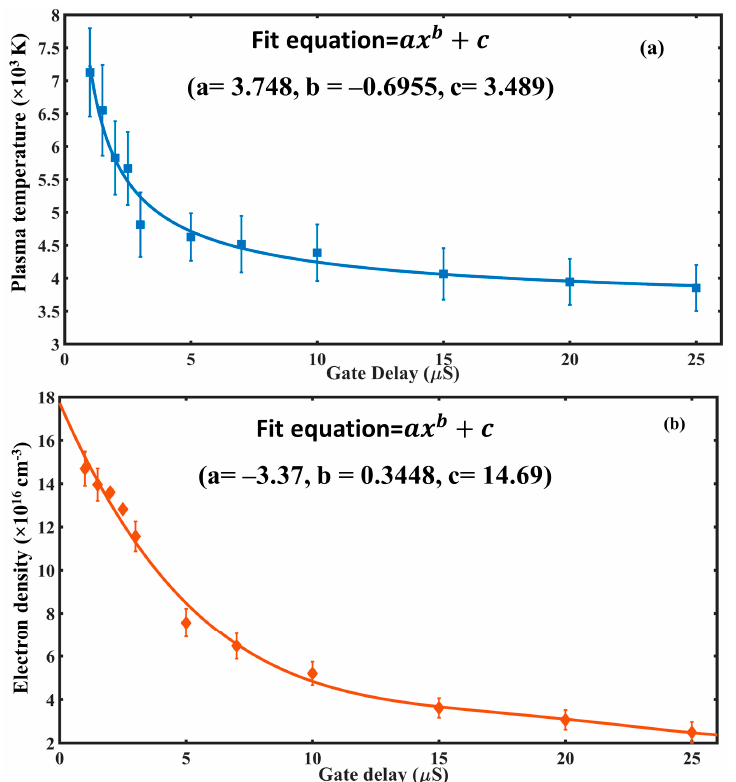
Figure 7. Temporal evolution of ( a ) plasma temperature and ( b ) electron density with varying gate delays. Data points are fitted with a power2 function in the MATLAB program. The constants are provided in the figure.